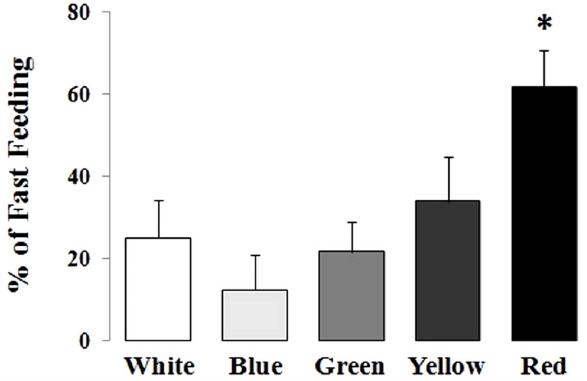
Figure 1. Mean ( ± SEM) percentage of days fish snatched food pellets within 10 s in each color treatment. N =6, except for the yellow N =5. Asterisk indicates the mean is different from the other groups (ANOVA, P , 0.05).